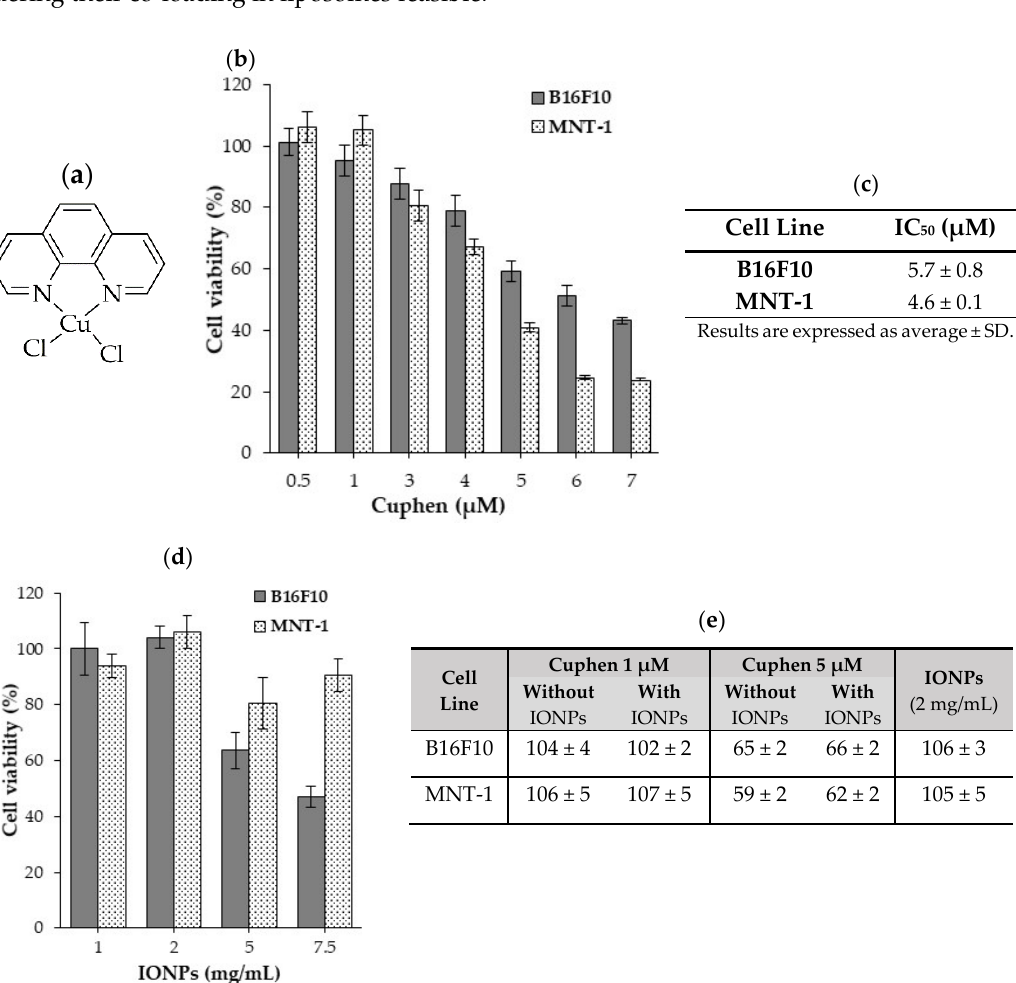
Figure 3. Evaluation of Cuphen and IONPs cytotoxic activity towards human (MNT-1) and murine (B16F10) melanoma cell lines. ( a ) Cuphen chemical structure; ( b ) cell viability after 24 h incubation with different Cuphen concentrations (0.5 to 7 µM); (c) Cuphen half-inhibitory concentration (IC 50 ) values; ( d ) cell viability after 24 h incubation with IONPs at a concentration ranging from 1 to 7.5 mg/mL; ( e ) cell viability after a 24 h incubation period with Cuphen (1 and 5 µM) in the presence or absence of IONPs at a concentration of 2 mg/mL. Data are expressed as mean percentage (%) of control ± SD of three independent experiments with six replicates each.